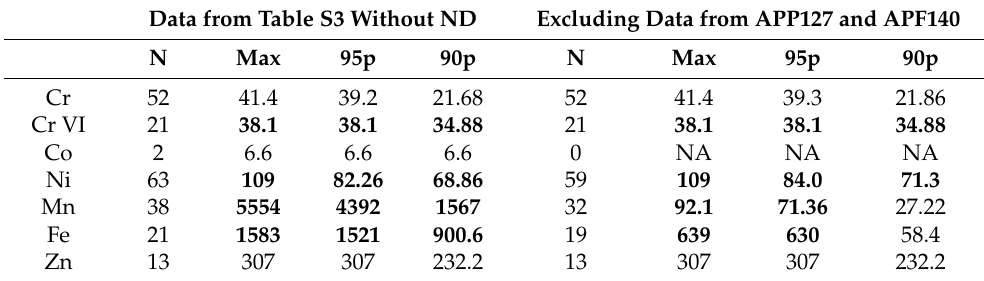
Table 7. PTE percentiles calculated using the total number of PTE measurements (in µ g/L) (Table S3). In bold, the values exceeding the TVs for water quality [15]. Data from Table S3 Without ND Excluding Data from APP127 and